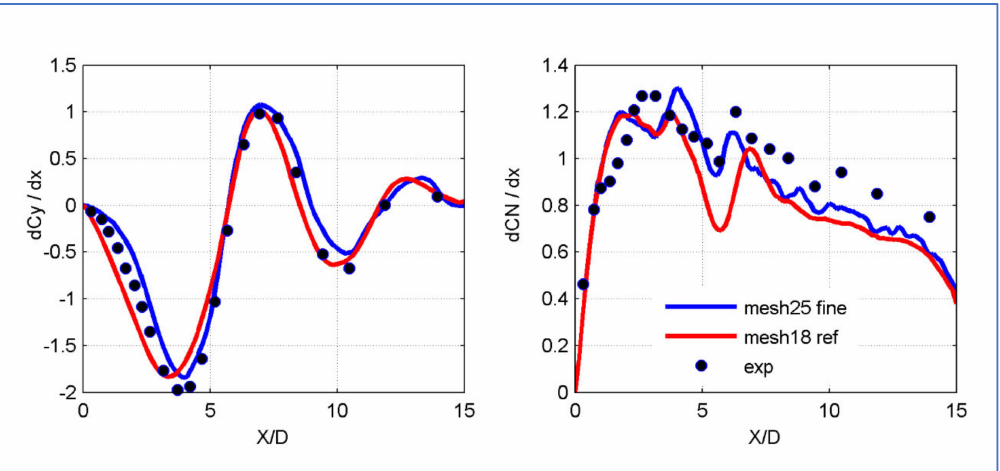
Figure 16. Averaged local side and normal force coefficients at Mach number Ma = 0.2, Reynolds number Re = 2 × 10 6 and angle of attack α = 45 degrees within a period of T = 0.5 s compared to experimental data (black dots). Grid U1 (red lines) and Grid U2 (blue